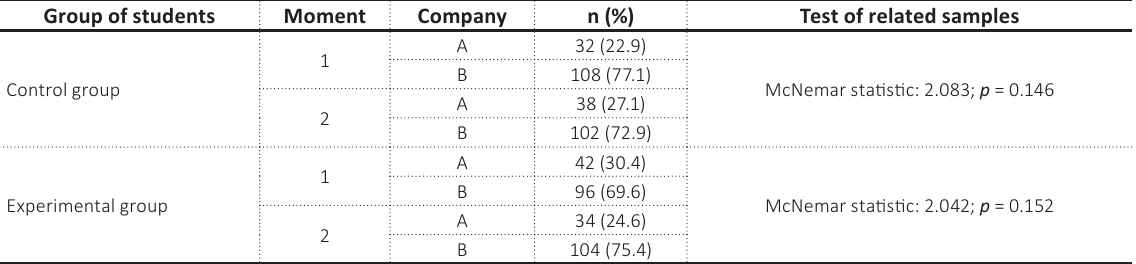
Table 4. Questionnaire trial 3: Results of choice between two company descriptions Group of